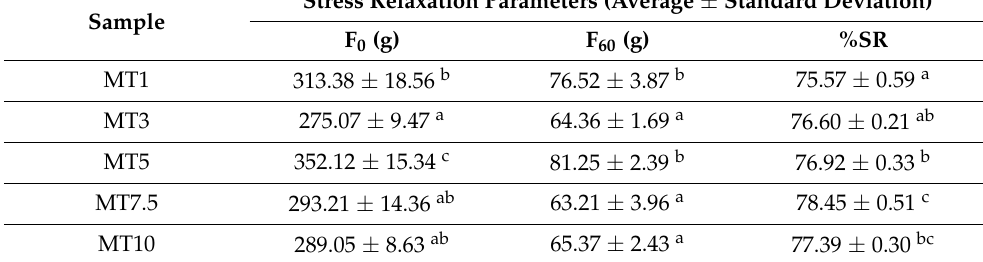
Table 3. Stress relaxation parameters. For each column, different letter(s) indicates significantly different values by the Tukey HSD